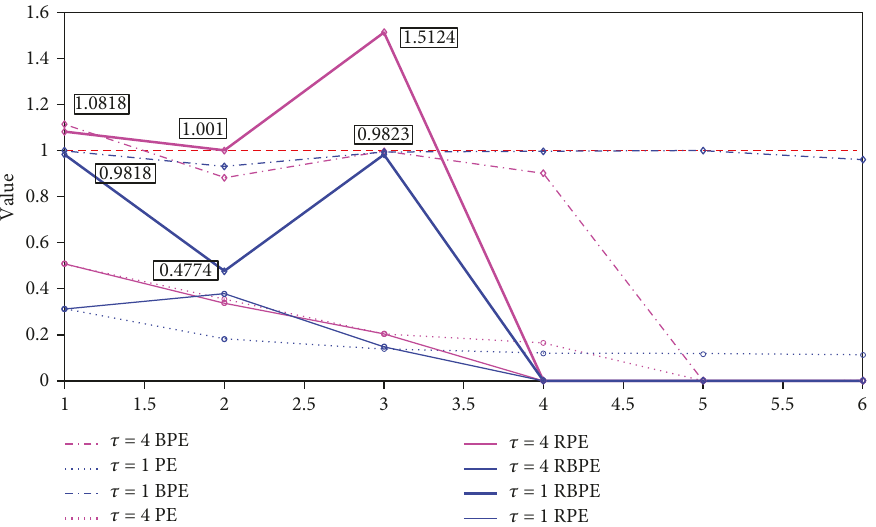
Figure 6: BPE and PE value of the IMFs in decomposition of reconstructed S